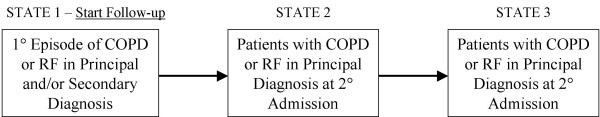
Markov Model at three "states" for patients with Chronic Obstructive Pulmonary Disease.